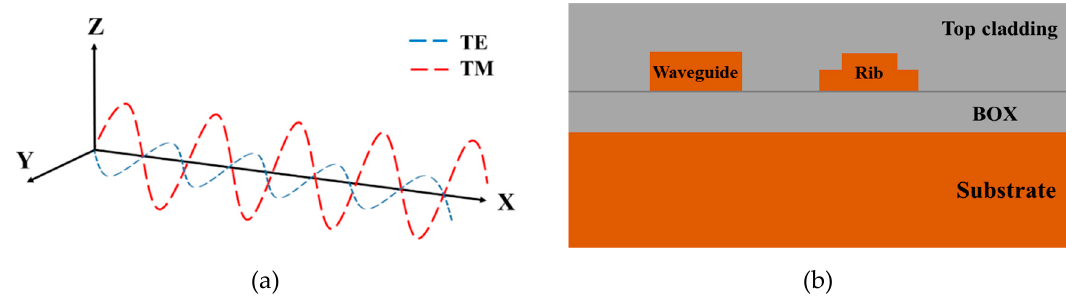
Figure 2. ( a ) Propagation of transverse electric (TE) and transverse magnetic (TM) mode; ( b ) layer composition of Si photonic circuits in a silicon-on-insulator (SOI) platform.